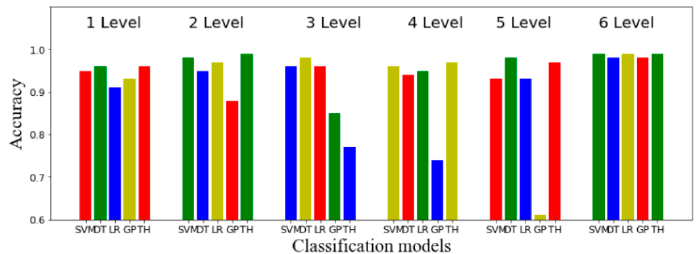
Figure 11. Accuracy for six activities using multiple classification approaches.